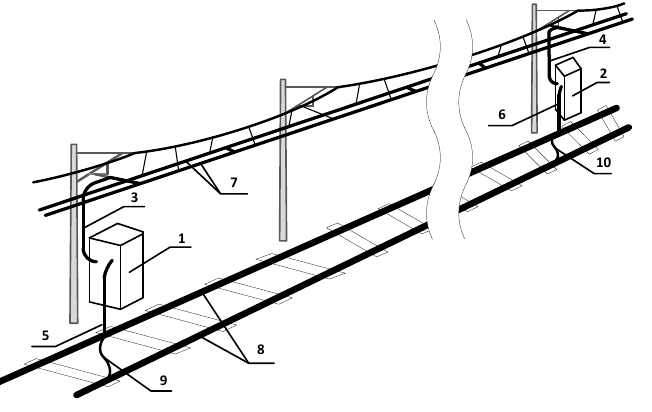
Figure 1. Structure of de-icing system.